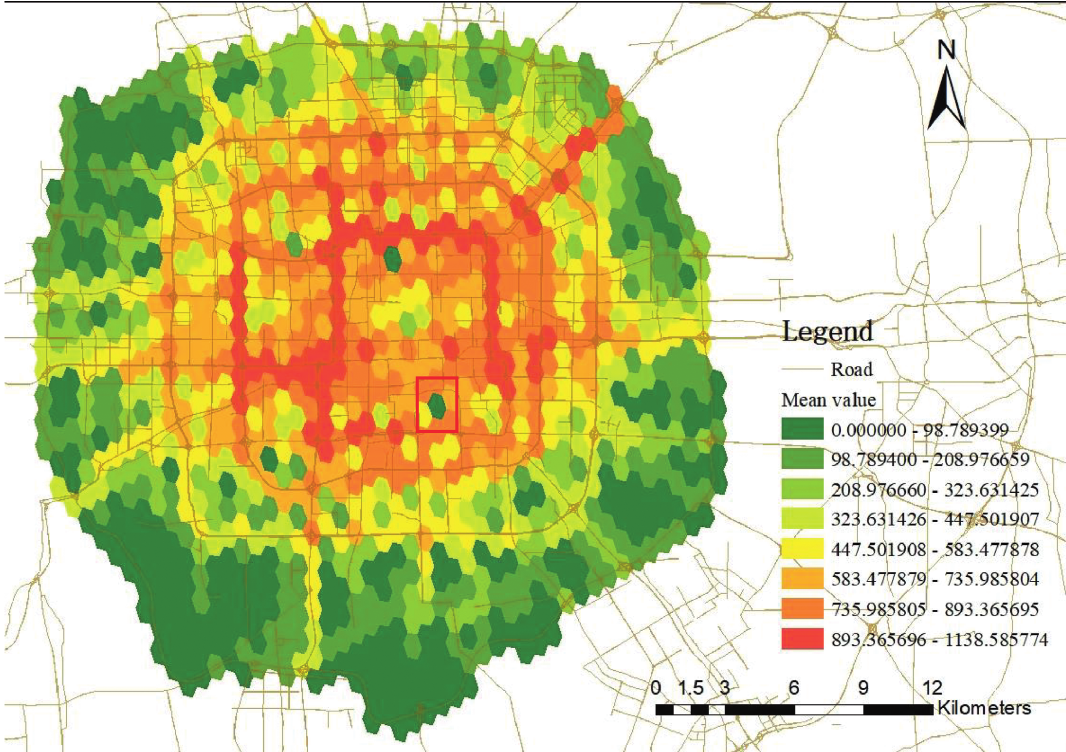
Figure 7: Comprehensive accessibility of healthcare